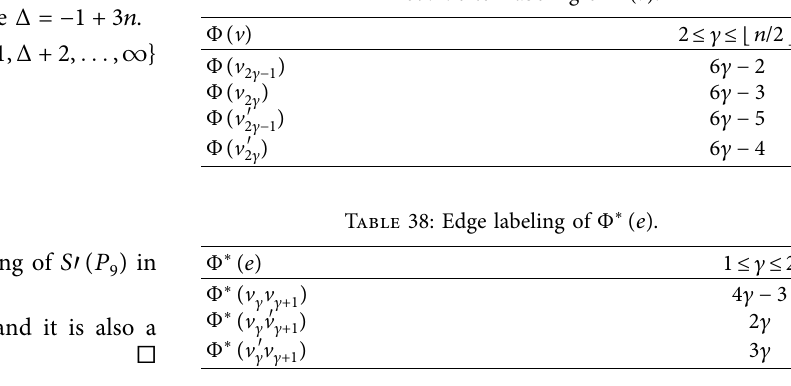
Table 37: Vertex labeling of Φ ( v ).